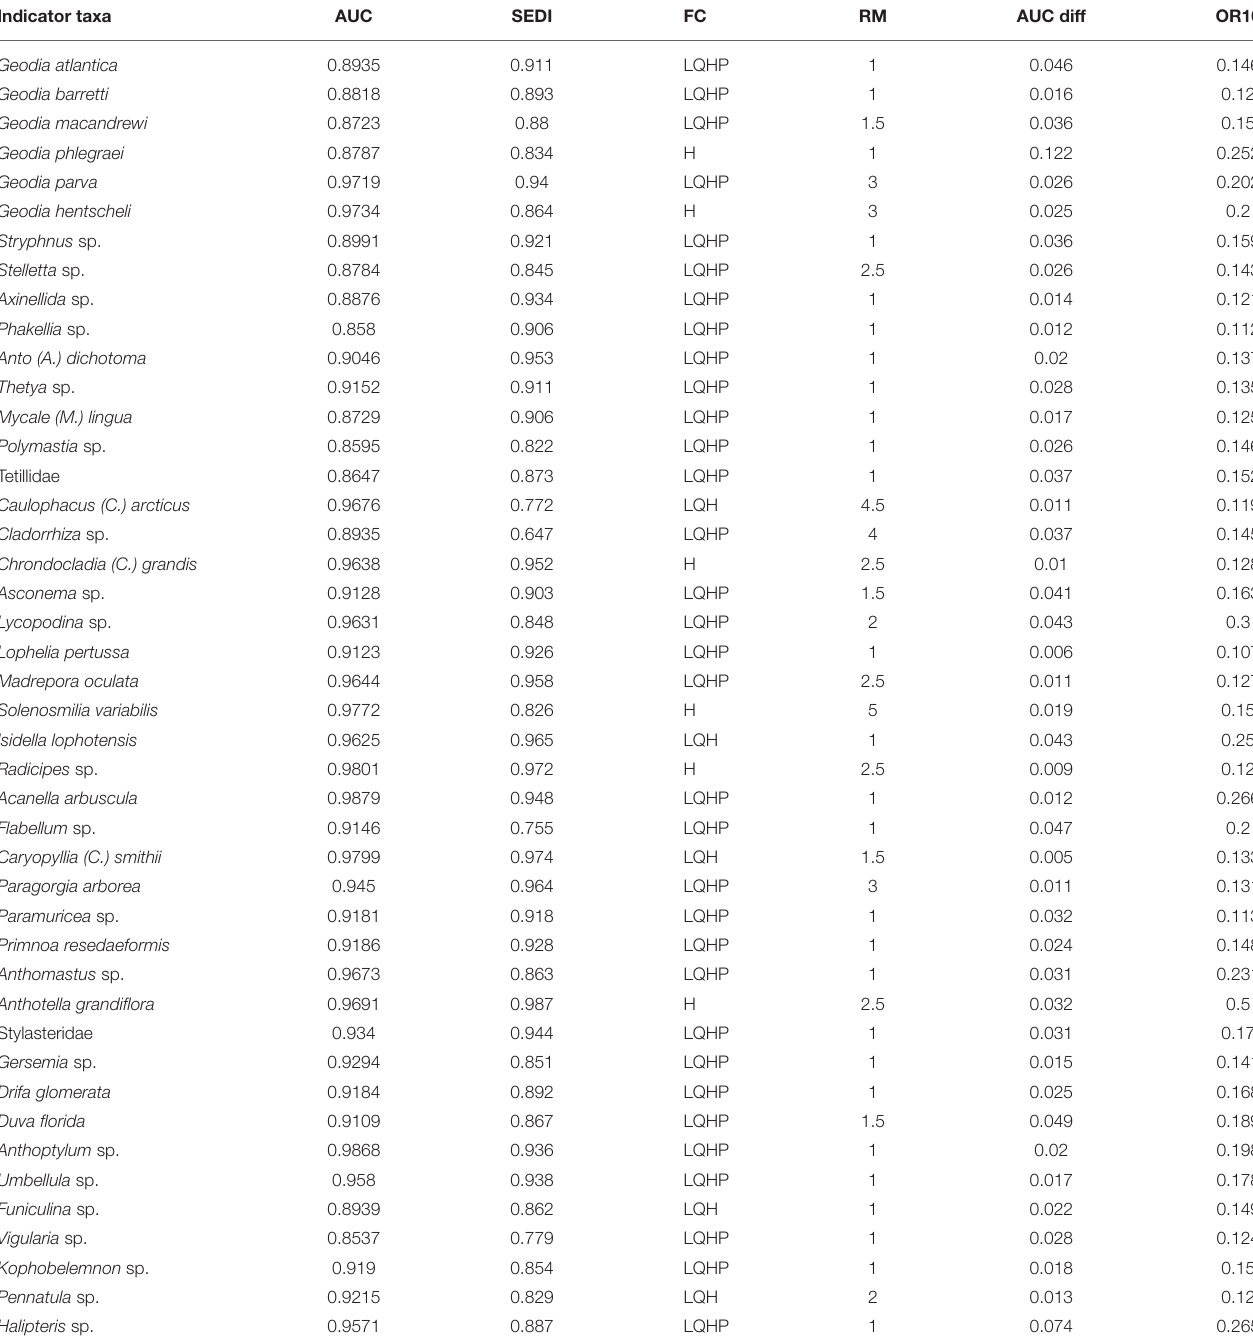
AUC indicates the average test AUC (area under the curve of the receiver operating characteristic plot). SEDI is the Symmetric Extremal Dependence Index computed using a maxSSS threshold. FC indicates the feature classes selected (L, Linear; Q, quadratic; H, hinge; P, product). RM is the value of the regularization multplier parameter. AUC diff is the